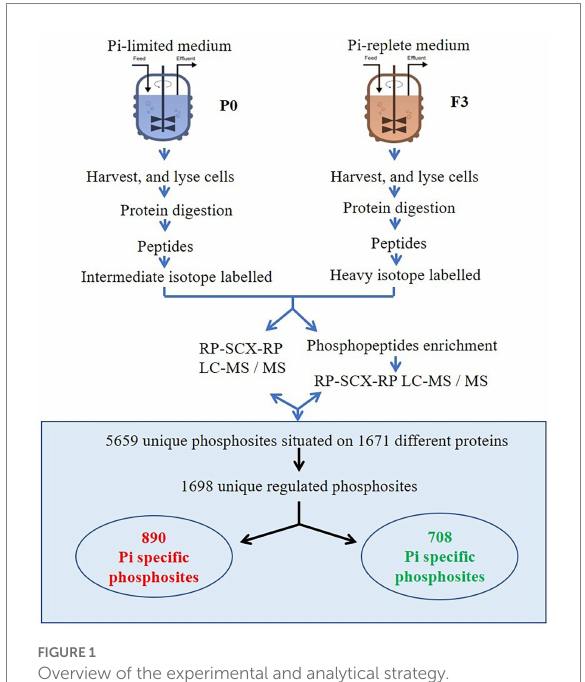
FIGURE 1 Overview of the experimental and analytical